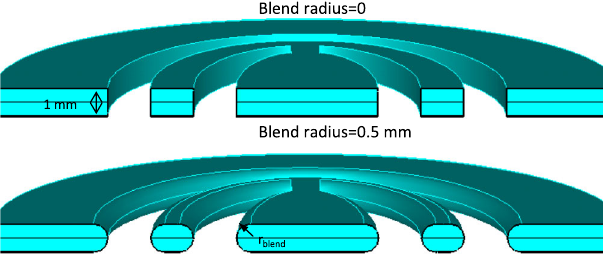
FIG. 7. Cross section of the CSRR used in the deflecting cavity with rectangular conductors (top) and edges smoothed with a blend radius of 0.5 mm (bottom).